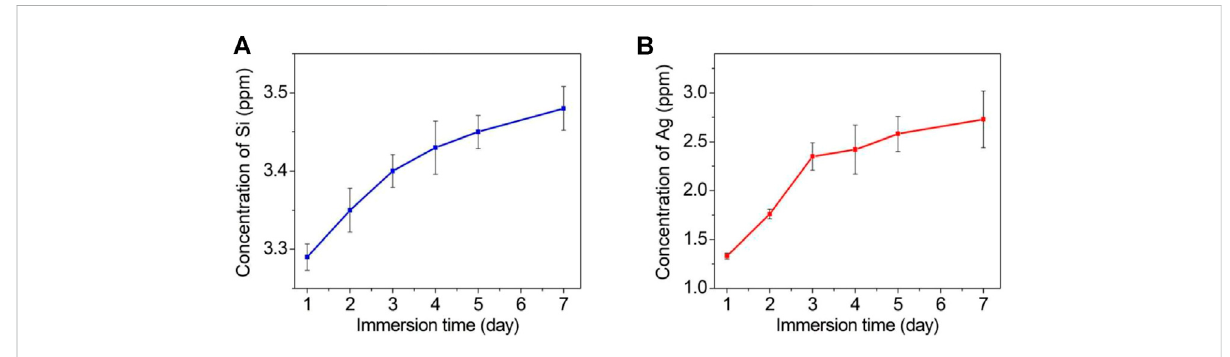
FIGURE 7 Cumulative release pro fi les for silicon ions (A) and silver ions (B) from the TCP-SA after immersion in PBS of different